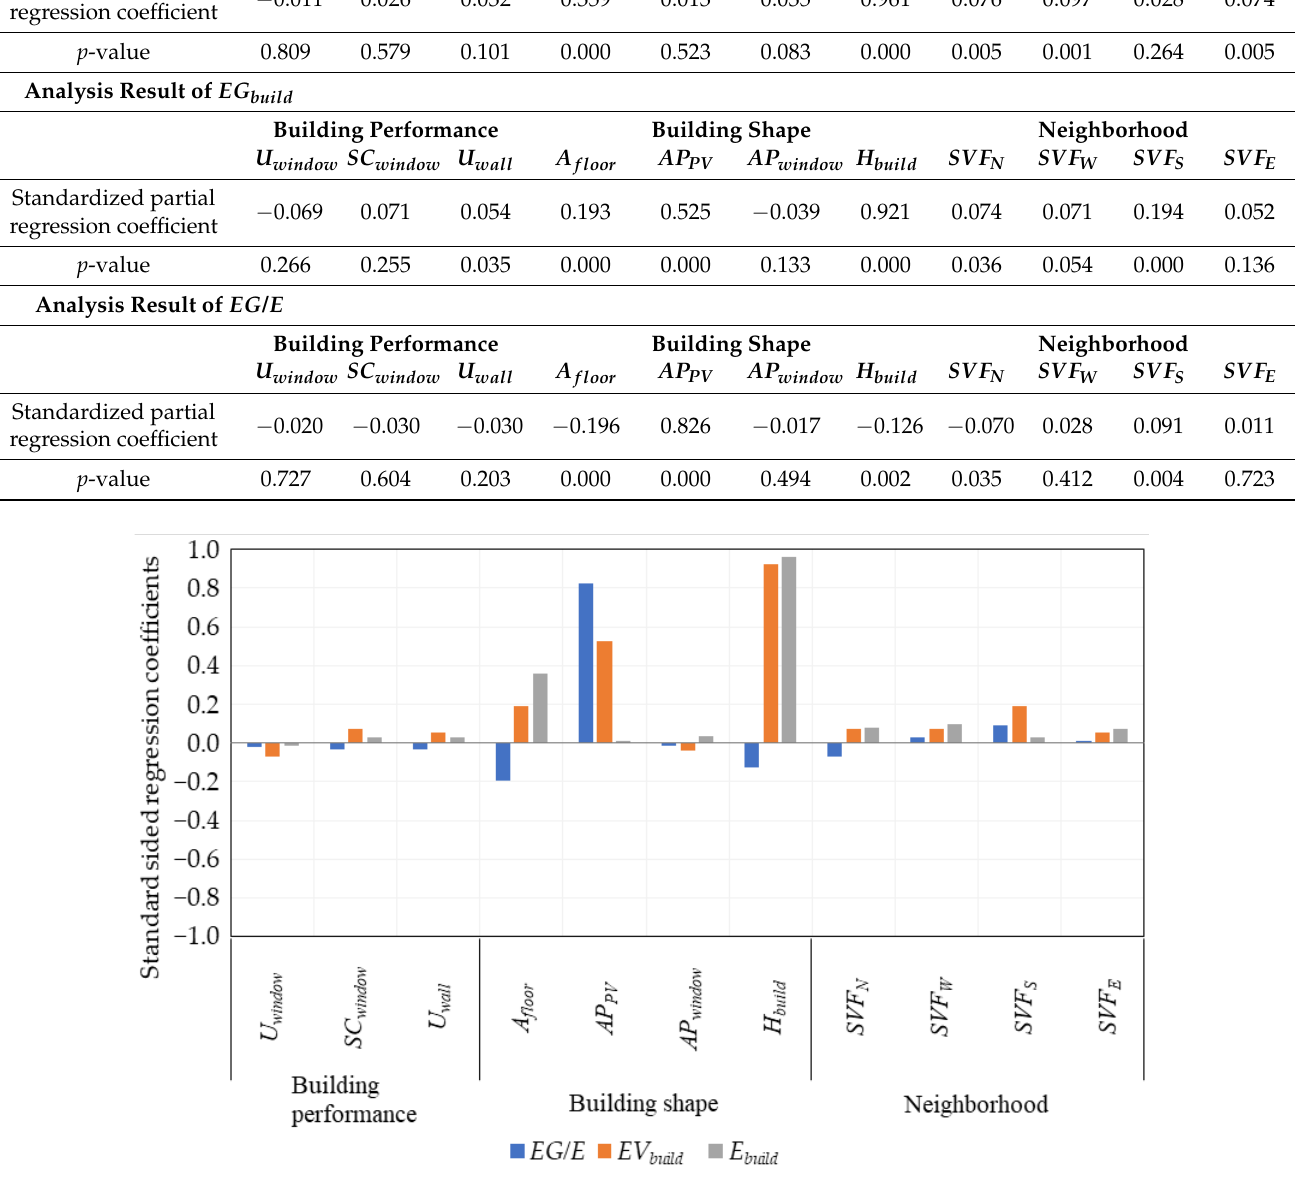
Figure 15. Standard-sided regression coefficients for independent variables.